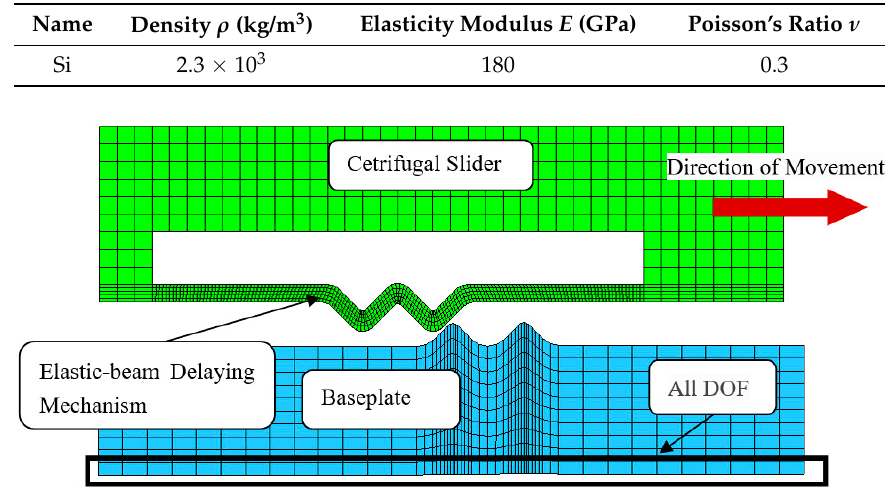
Figure 8. The infinite model of elastic-beam delaying mechanism.